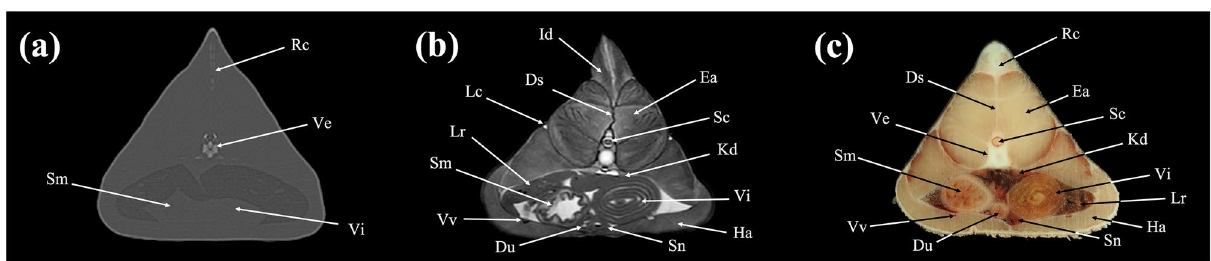
Figure 10. Transverse ( a ) CT, ( b ) MR, and ( c ) cryosection images of a banded houndshark ( Triakis scyllium ) at level 10 of Fig. 25. Ds Dorsal median septum, Du Duodenum, Ea Epaxial, Ha Hypaxial, Id Inclinator dorsalis, Kd Kidney, Lc Lateral line canal, Lr Liver, Rc Radial cartilage, Sc Spinal cord, Sm Stomach, Sn Spleen, Ve Vertebra, Vi Valvular intestine, Vv Ventral abdominal